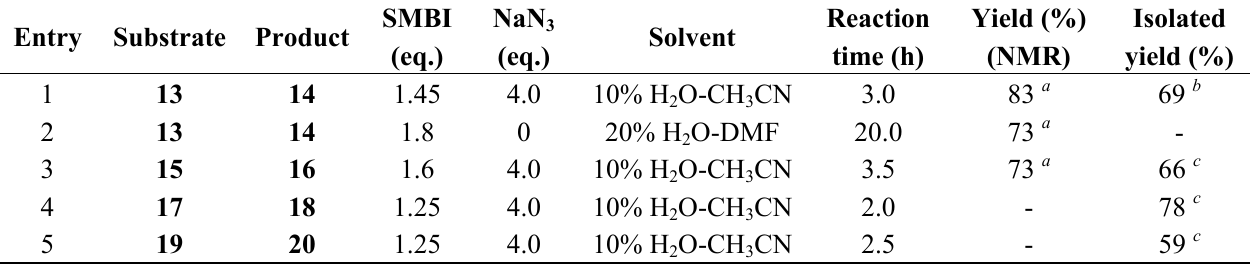
Table 2. Comparison of suitable bromination condition for cytidine and bromination of cytidine